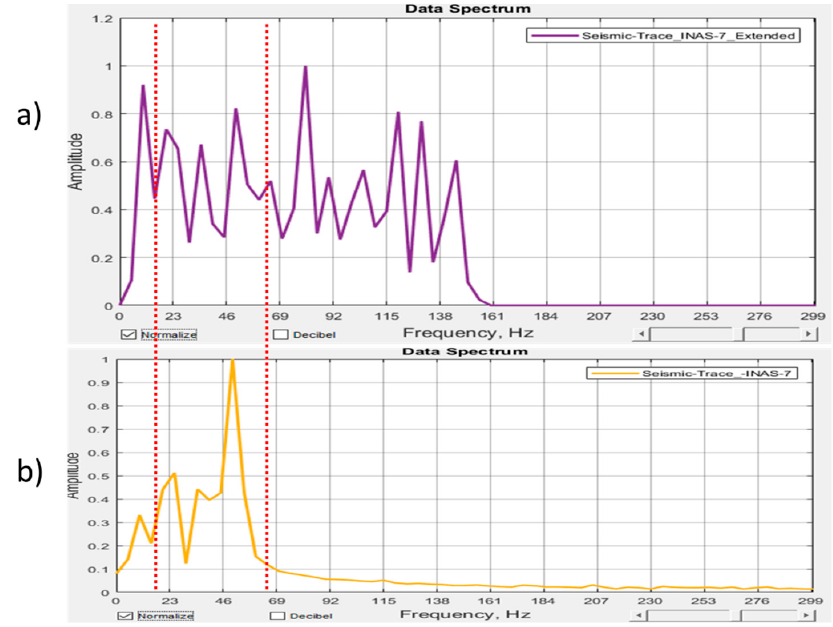
Figure 14. ( a ) Data spectrum of the enhanced trace model ( b ) and spectrum of the original model trace